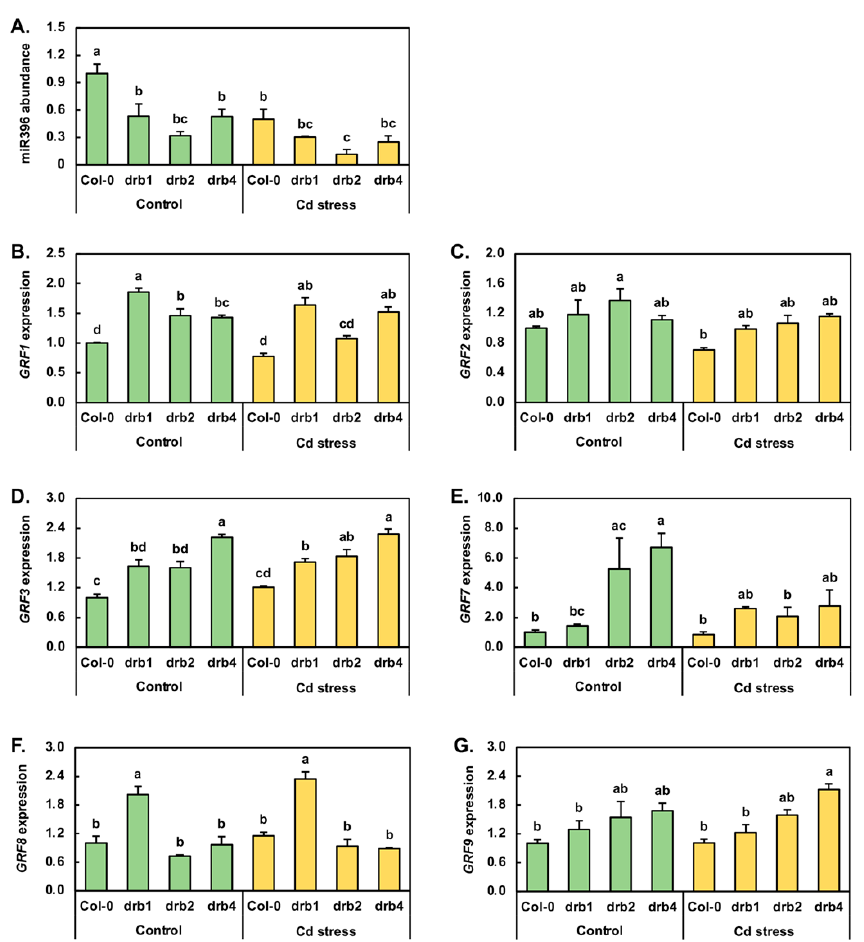
Figure 5. RT-qPCR quantification of the miR396 abundance and GRF target gene expression in control and cadmium-stressed Col-0, drb1 , drb2 and drb4 plants. Quantification of miR396 abundance ( A ) and the expression of its GRF target genes, GRF1 ( B ), GRF2 ( C ), GRF3 ( D ), GRF7 ( E ), GRF8 ( F ) and GRF9 ( G ), via RT-qPCR assessment of 15-day-old control and Cd-stressed Col-0, drb1 , drb2 and drb4 whole seedlings. ( A – G ) Statistical data were analyzed using one-way ANOVA and Tukey’s post-hoc tests. The statistically significant differences are indicated by a different letter ( p -value < 0.05) above each column of each histogram.